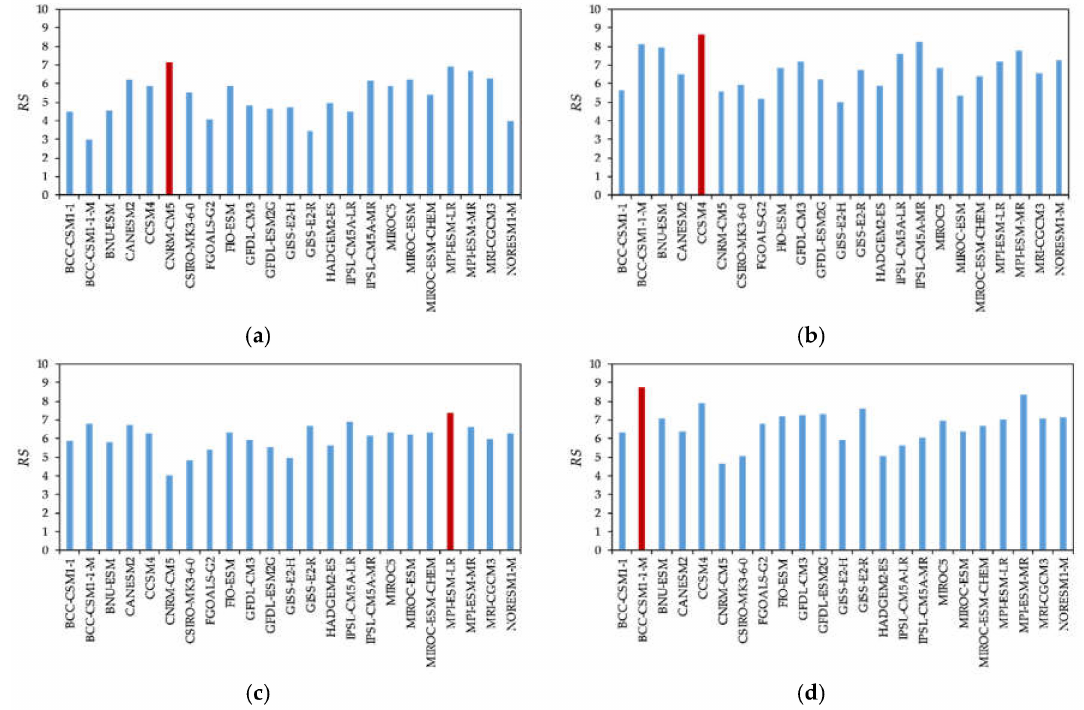
Figure 2. Results of performance evaluation from 23 GCMs by the score-based method for ( a ) precipitation; ( b ) mean air temperature; ( c ) maximum air temperature; and ( d ) minimum air temperature.